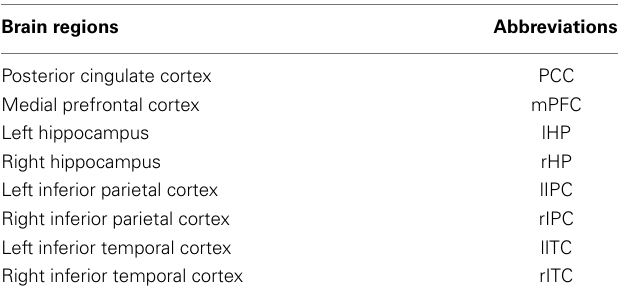
Table 1 | Brain regions and the corresponding abbreviations of eight ROIs in the DMN